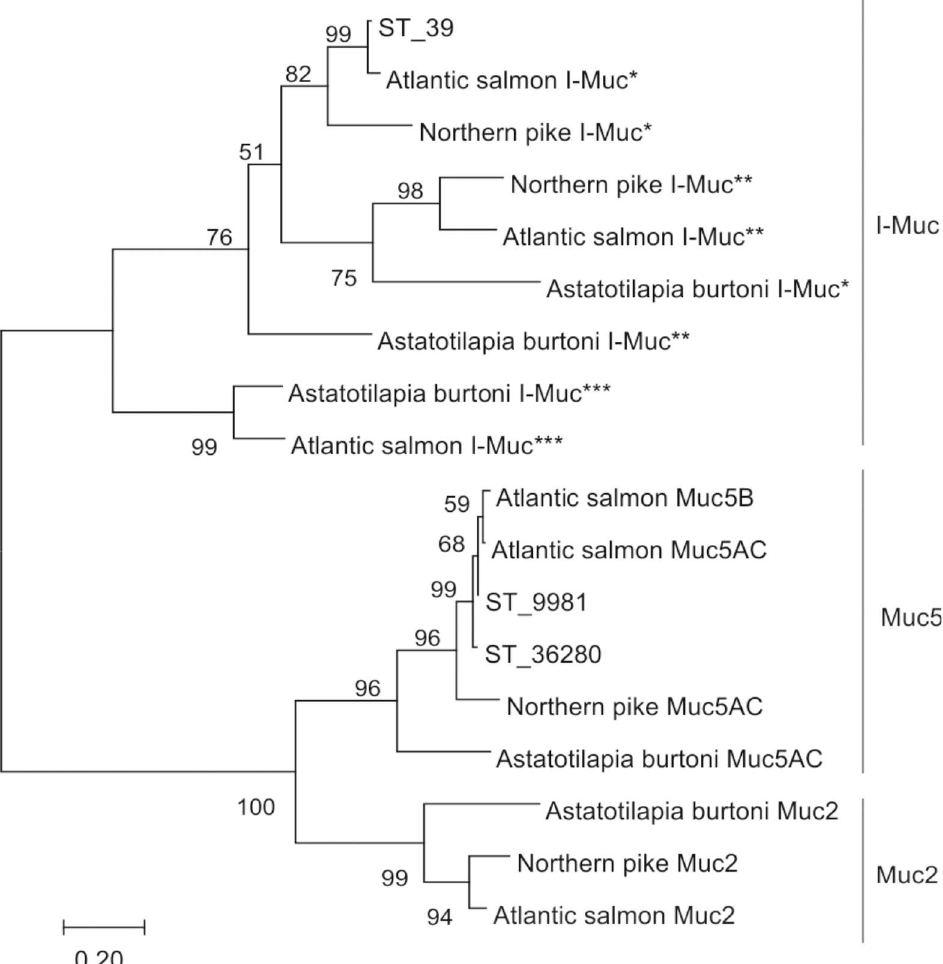
of the VWD and C8 domainsof the translated(ST_9981, ST_36280, ST_39)and selectedteleost families: Salmonidae, Esocidae,and Cichlidae. The maximum likelihoodphylogenyin MEGA 7 [61]was selected. The tree was bootstrapped 1,000 times. Accessionnumbers:Atlantic salmonI-Muc * (XP_014041914),northern pike I-Muc * (XP_012994242.1),northernpike I-Muc ** (XP_012993966.1),Atlantic salmonI-Muc